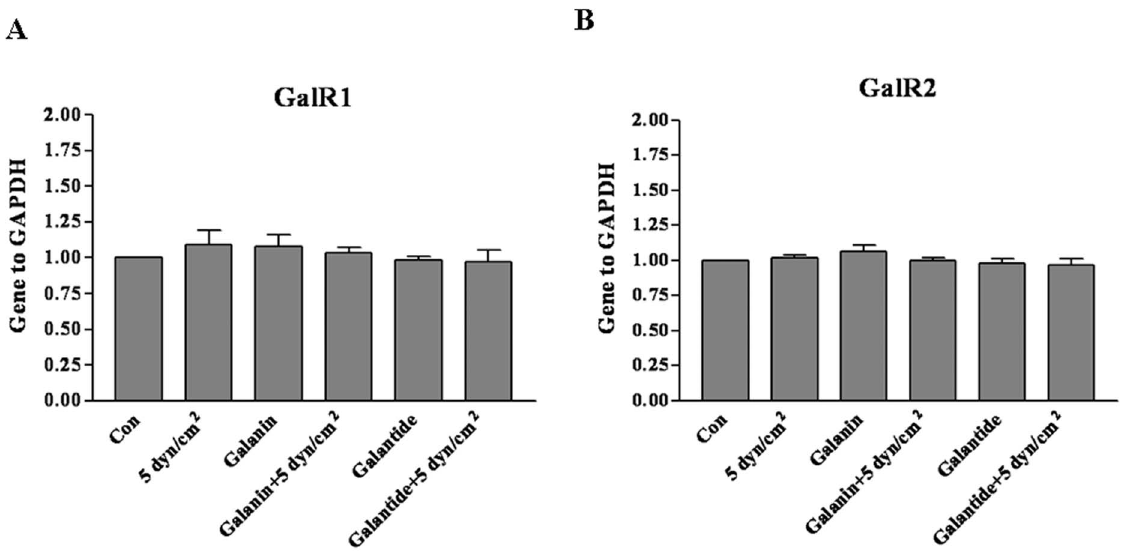
Figure 4. Expressions of mRNAs for GalR1, R2 and R3 after shear stress of 5 dyn/cm 2 for 12 h. Quantitative real time PCR results show that GalR1 (Fig. 4A)and GalR2 (Fig. 4B) did not change significantly, and there was no GalR3 expression in the cortical neurons with galanin or galantide treatment after shear stress of 5 dyn/cm 2 for 12 h. The data are presented as mean 6 SD (n=3).